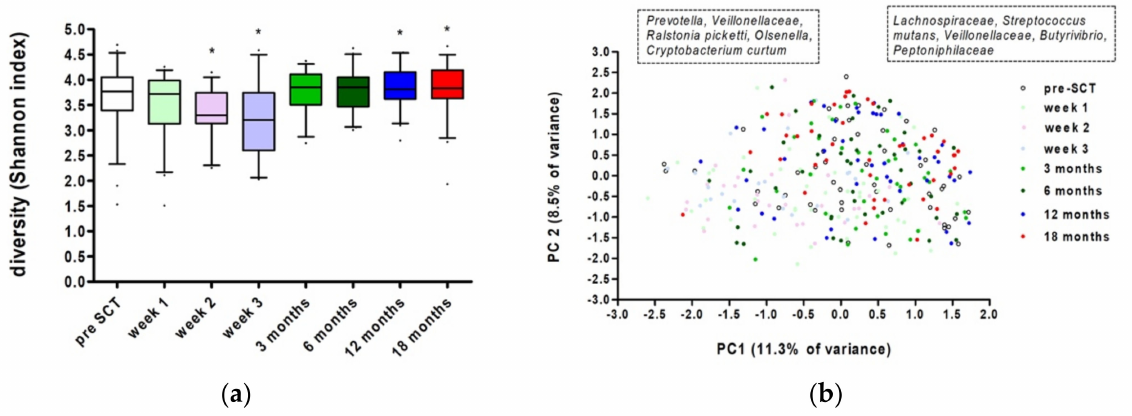
Figure 1. Oral microbiome at all time points in the study: ( a ) Shannon diversity index (boxes show median and whiskers 5–95 percentile). * Marks significant differences compared to pre-SCT (Linear Mixed Model Analysis, p < 0.05); ( b ) principal component analysis plot. Left box indicates more abundant taxa at low values of the loadings of PC1, right box—at high